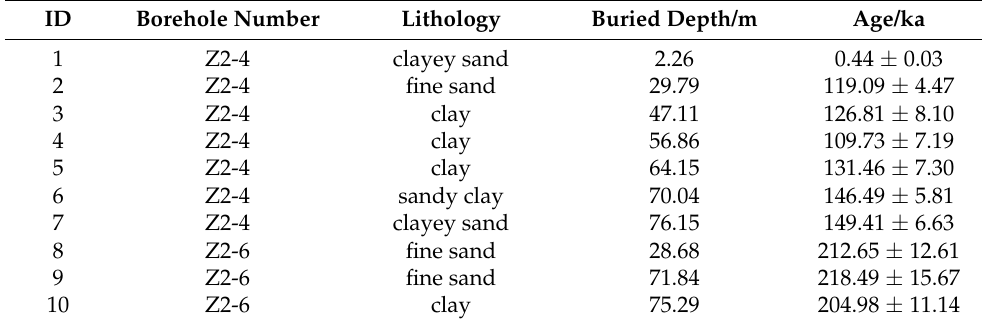
Table 5. The dating results of OSL samples in Lizui